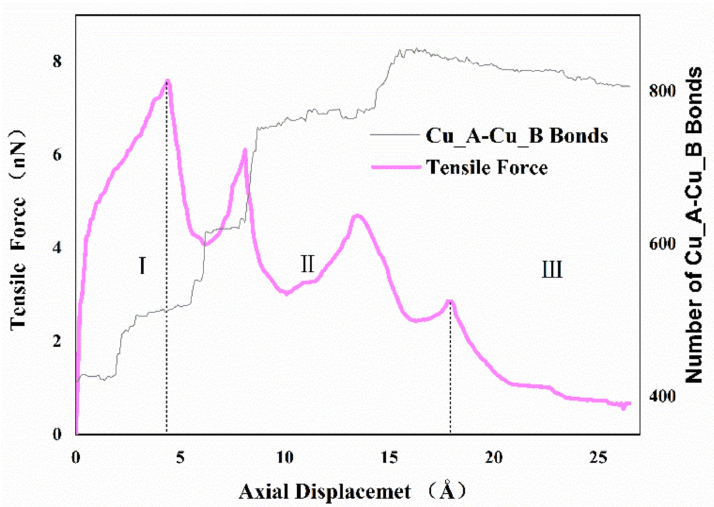
Figure 4. Variation of the tensile loading force and the number of Cu_A-Cu_B bonds with the axial displacement for nanocones, with an initial axial separation of 20 Å and a contact length of 20